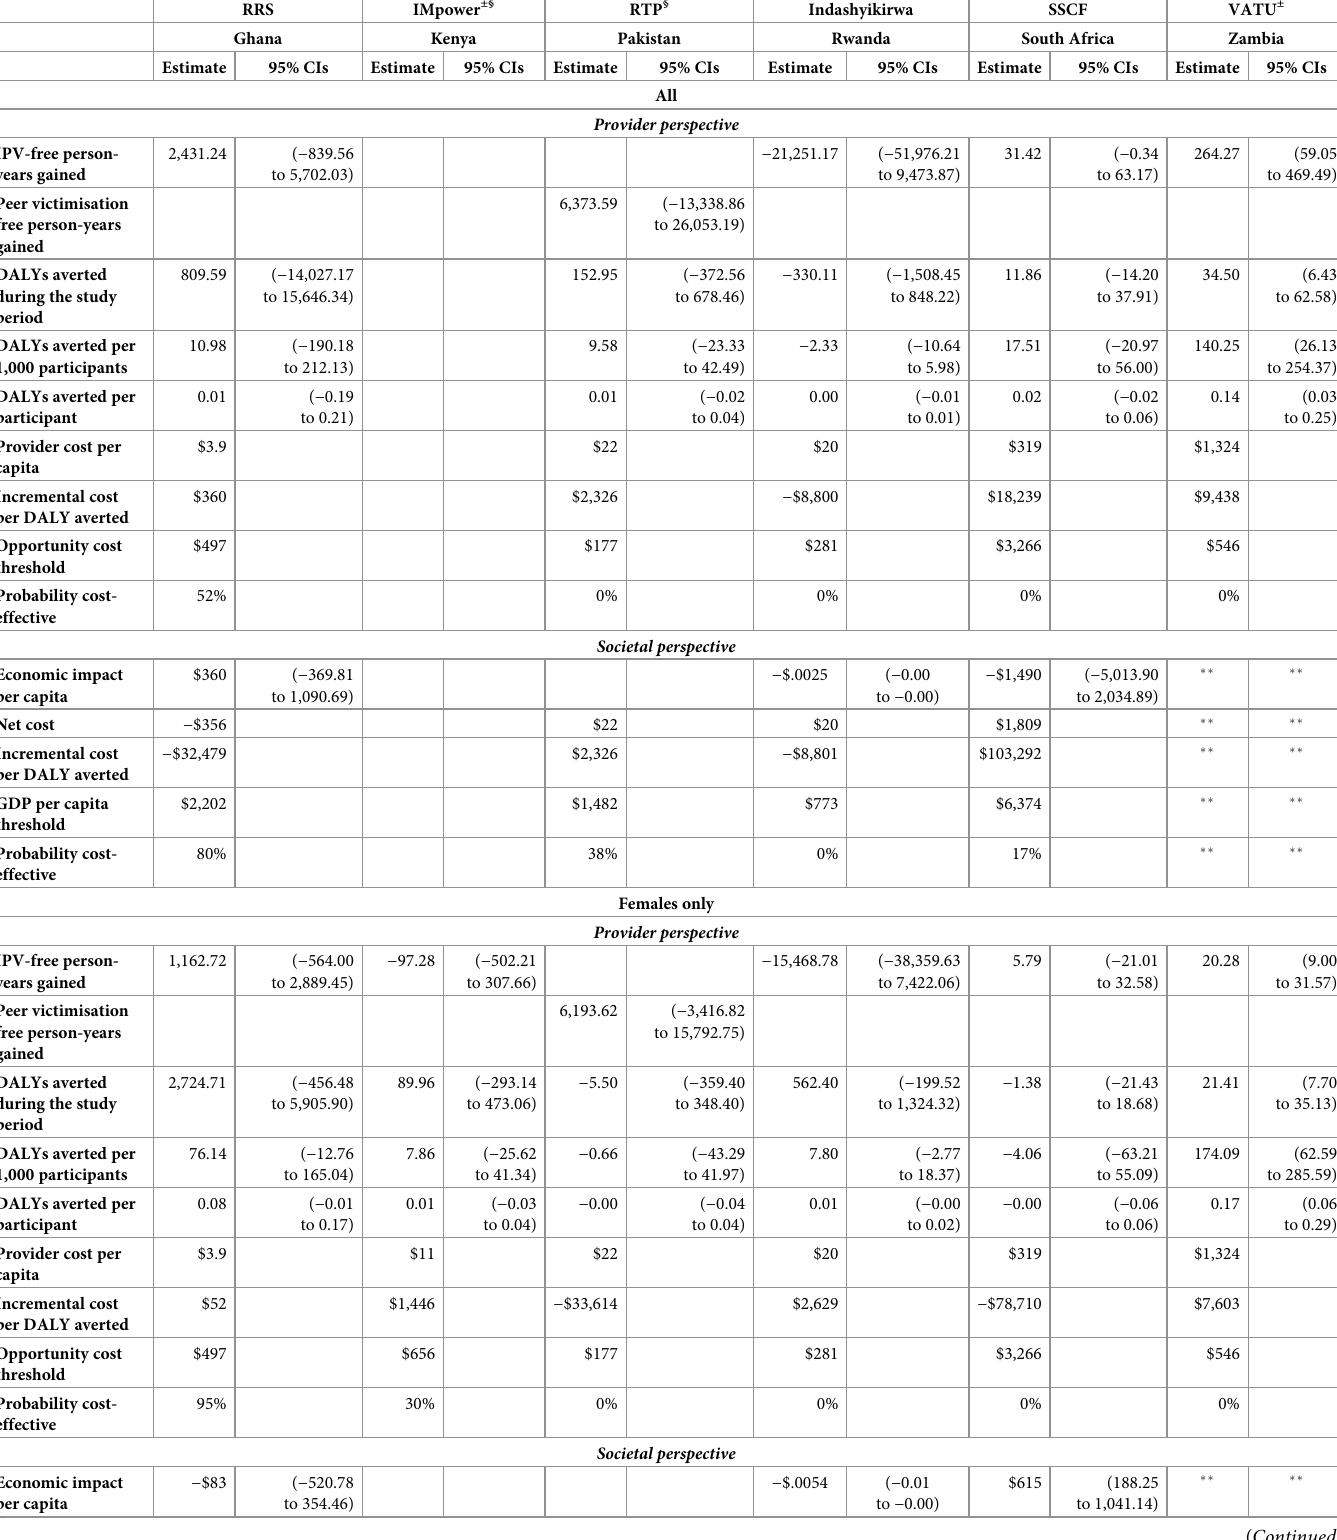
Table 4. Cost-effectiveness �